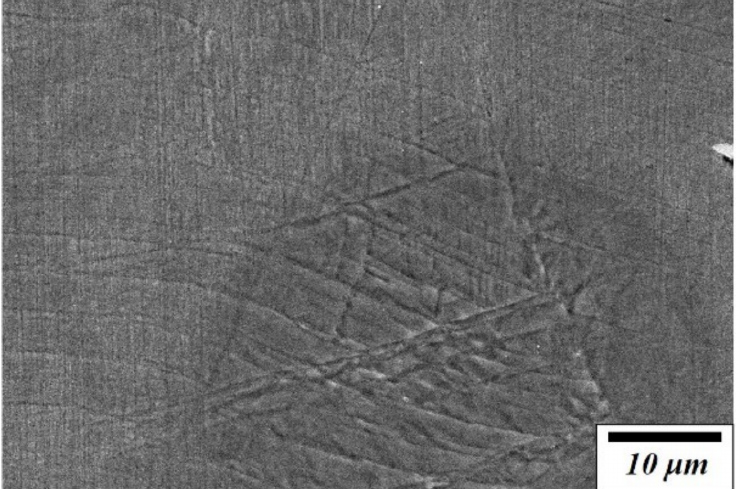
Figure 2. SEM image of Fe-22%Mn-12%Cr-4%Co-3%Ni-2%Si damping alloy damaged under 175-MPa fatigue